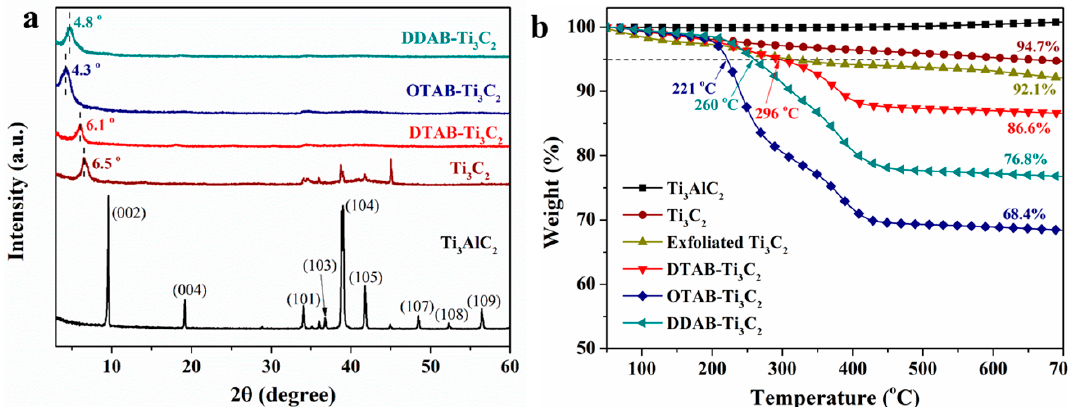
Figure 1. X-ray diffraction (XRD) patterns of Ti 3 AlC 2 , Ti 3 C 2 , DTAB-Ti 3 C 2 , OTAB-Ti 3 C 2 and DDAB-Ti 3 C 2 ; thermogravimetric analysis (TGA) curves of Ti 3 AlC 2 , Ti 3 C 2 , exfoliated Ti 3 C 2 , DTAB-Ti 3 C 2 , OTAB-Ti 3 C 2 and DDAB-Ti 3 C 2 . a.u. = arbitrary units.